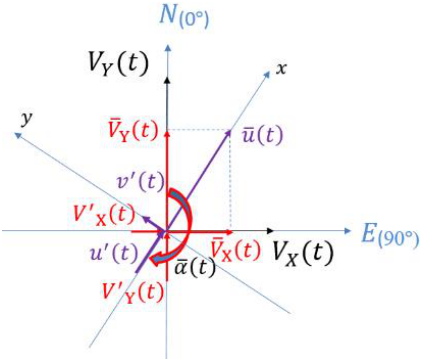
Figure 2. Directional signal decomposition.